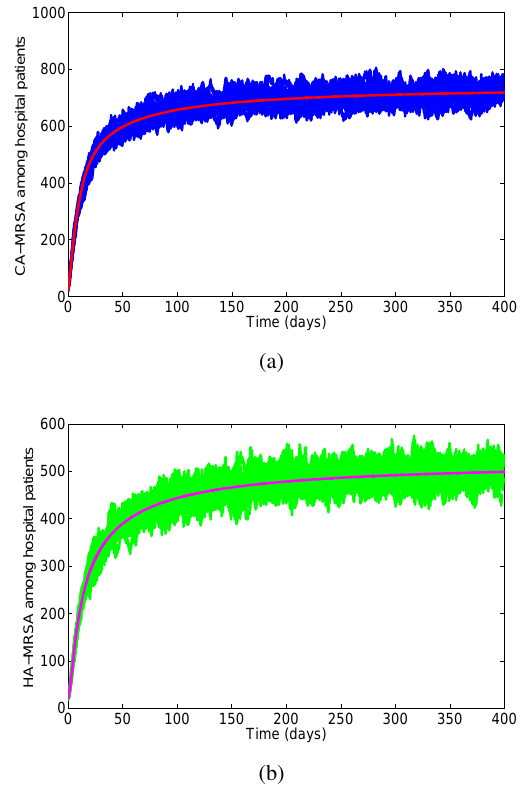
Fig. 6. Simulation of stochastic model (2.1) as a function of time using 20 realizations. (a). Total number of hospital patients with CA-MRSA; and (b). Total number of hospital patients with HA-MRSA,